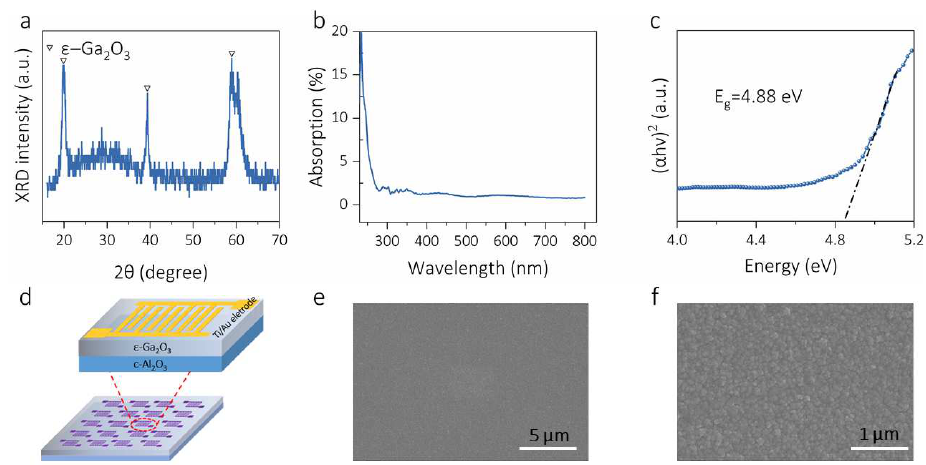
Figure 1. ( a ) X-ray pattern of the ε -Ga 2 O 3 thin film; ( b ) absorption spectrum; ( c ) extrapolation of the bandgap diagram using the Tauc equation; ( d ) enlarged view of the photodetector array unit; ( e , f ) surface topography of the ε -Ga 2 O 3 thin film.